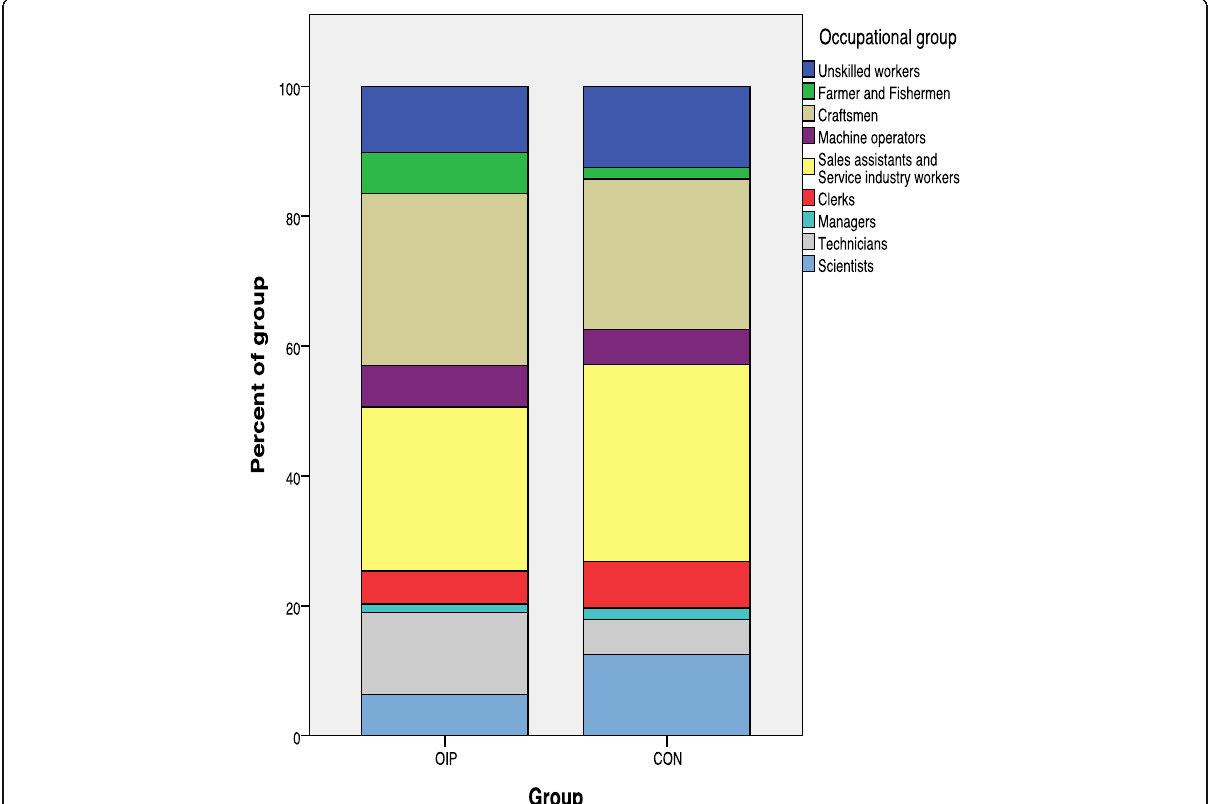
Fig. 1 Distribution of patients in the OIP and CON groups according to occupational categories of the International Standard Classification of Occupations (ISCO-88) (Bundesamt für Statistik 2017). Legend: OIP = occupational injuries patients, CON =